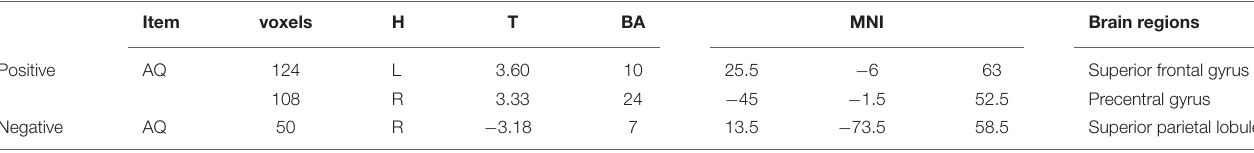
TABLE 3 | The positive correlation between gray matter density and Autism Spectrum